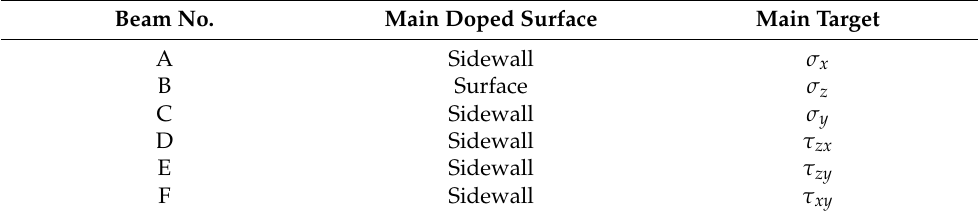
Table 1. Relationships between doped surfaces and main target stresses. Beam